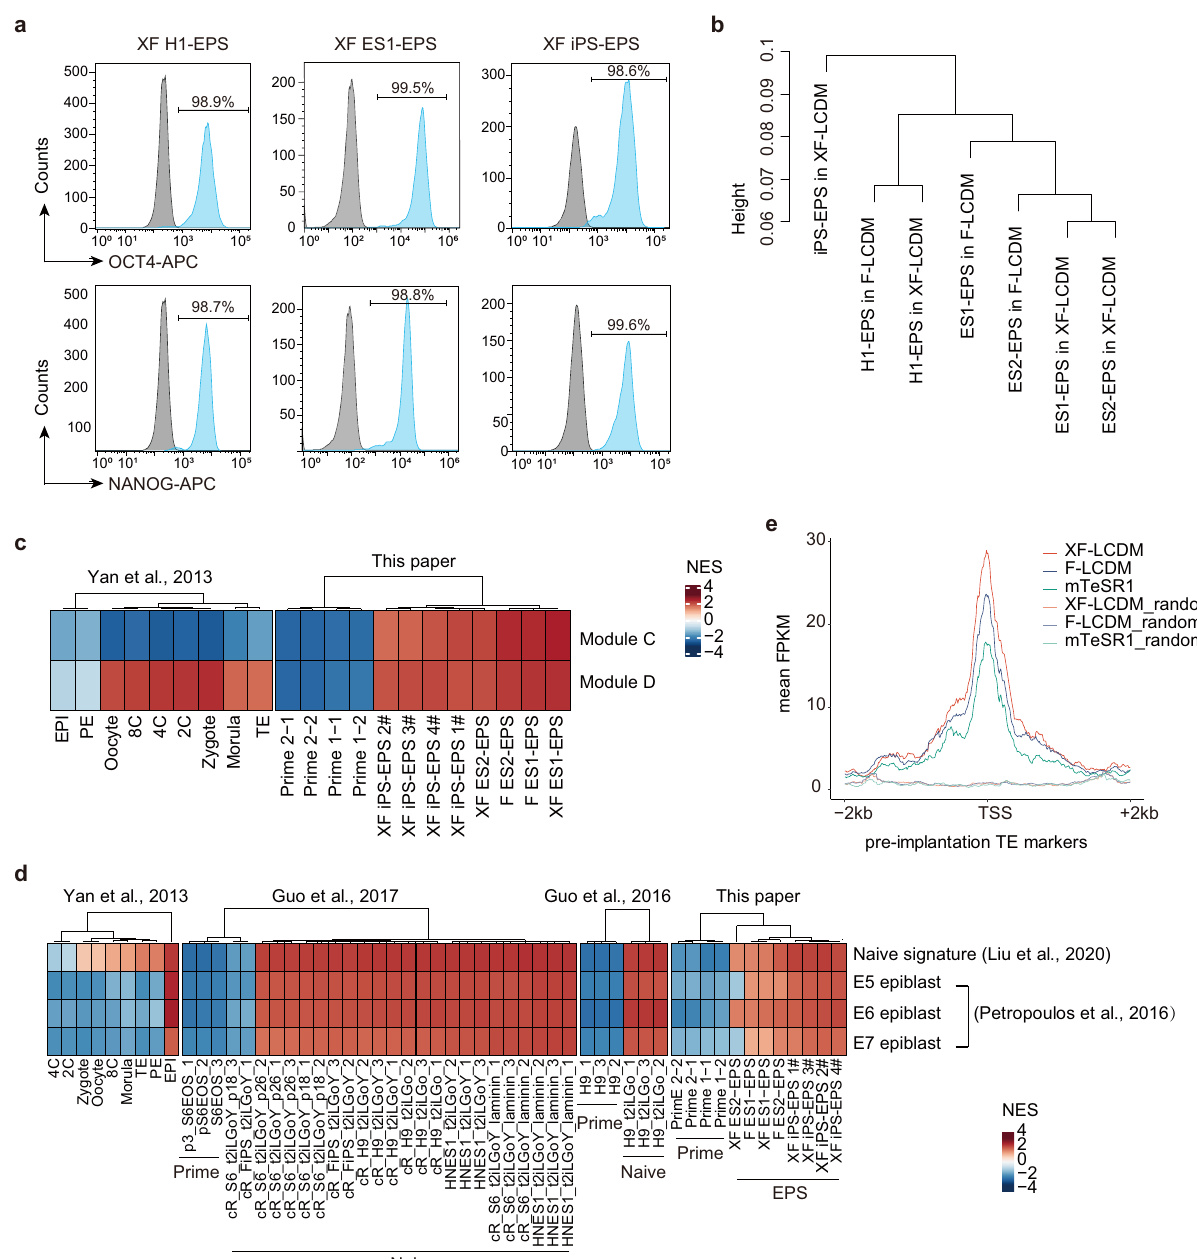
Fig. 3 Characterization of molecular features of xeno-free human EPS cells. a Representative FACS analysis of the percentages of OCT4 + or NANOG + cells in xeno-free hEPS cells. b Hierarchical clustering of global gene expression of EPS cells cultured in XF-LCDM and F-LCDM. Distance is calculated by 1- Spearman correlation coef fi cient. c GSEA analysis of enrichment of module C and module D in xeno-free and feeder-cultured hEPS cells. Bulk RNA-seq data for xeno-free and feeder-cultured hEPS cells were used. Gene signatures for module C and module D were de fi ned in our previous study (Yang et al.) 6 . As the control, dataset for pre-implantation human embryos (GSE36552, Yan et al.) 20 were chosen. d GSEA analysis of enrichment of gene signatures for E5/ E6/E7 epiblasts or naive pluripotent stem cells in xeno-free and feeder-cultured hEPS cells. Bulk RNA-seq data for xeno-free and feeder-cultured hEPS cells were used. Gene signatures for E5/E6/E7 epiblasts were de fi ned in the study performed by Petropoulos et al. 19 , and naive signatures were de fi ned in the study performed by Liu et al. 35 . As the control, dataset for pre-implantation human embryos (GSE36552, Yan et al.) 20 , and naive or primed hPSCs (E- MTAB-4461, Guo et al.; E-MTAB-5674, Guo et al.) 17,21 were chosen. e Mean FPKM values at TE marker genes in XF-LCDM, F-LCDM and mTeSR1 cultured primed cells. The signal density of given region (2 kb up- and down- streams of TSS) and randomly selected genome regions of the same length were analyzed. TE marker genes were de fi ned in the study performed by Petropoulos et al. 19